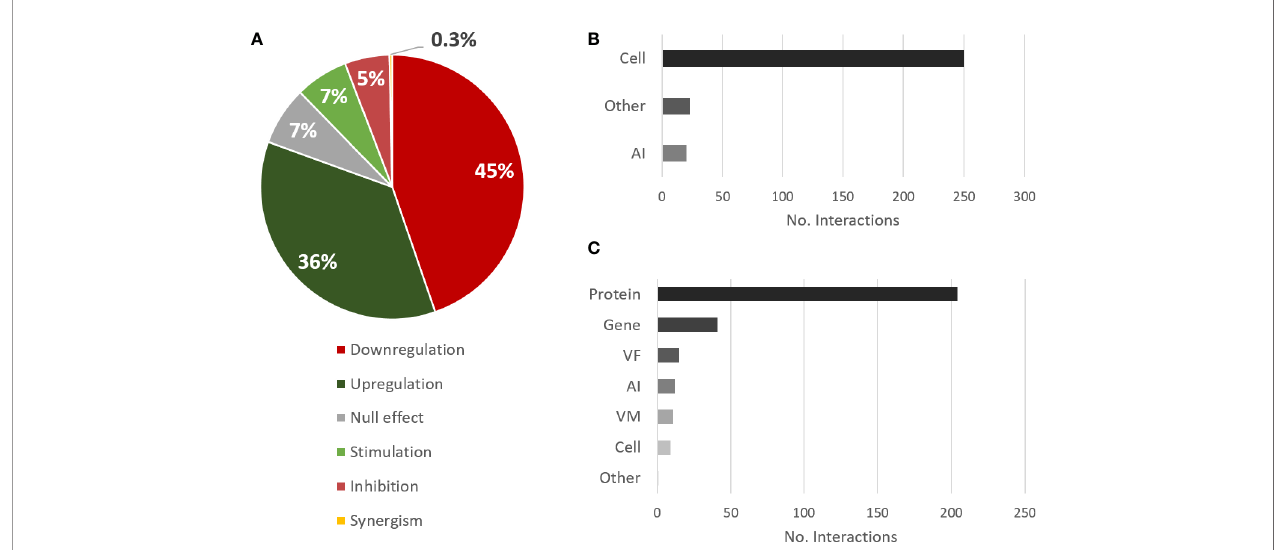
FIGURE 4 | Overview of the types of interactions and entities annotated for the effects of C. albicans on P. aeruginosa . (A) Proportional data on the types of interactions; (B) Total number of interactions annotated for each source category; (C) Total number of interactions annotated for each target category. Legend: AI, autoinducer; VM, virulence mechanism; VF, virulence